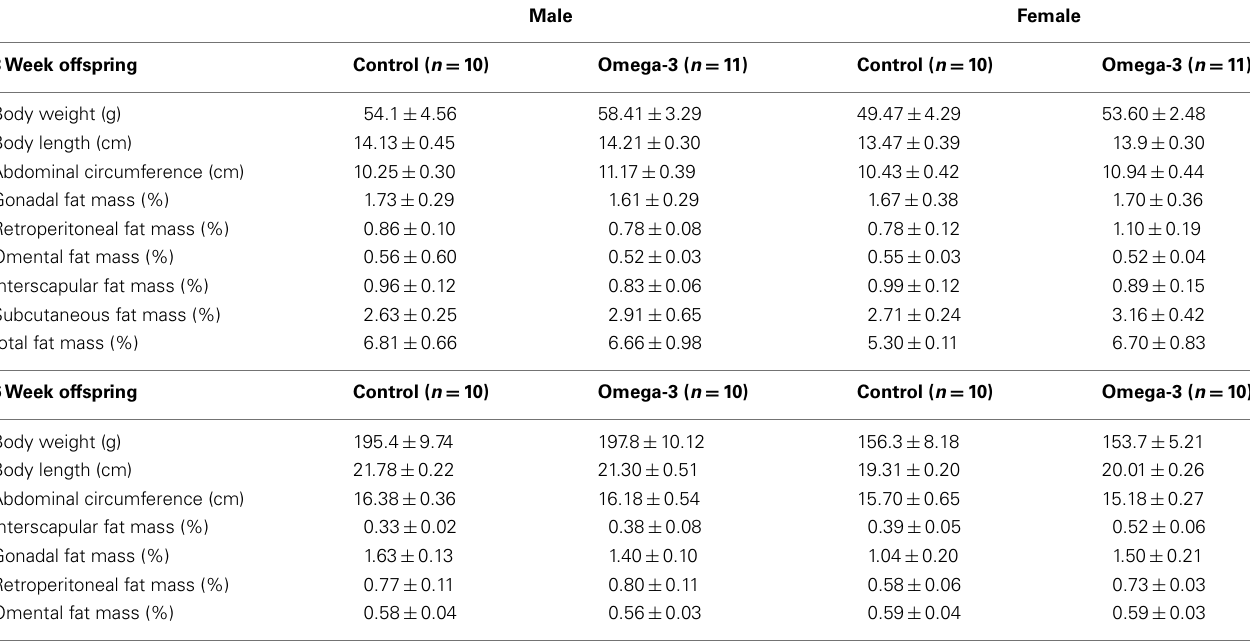
Table 5 | Pup body weight, size, and percentage fat mass at 3 and 6weeks of age in offspring of Control and Omega-3